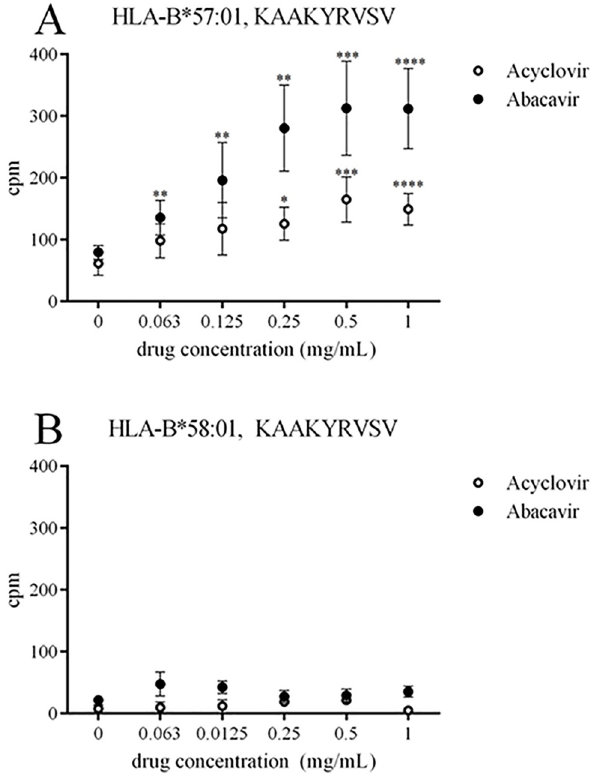
Fig 6. Acyclovir and abacavir alter the binding specificity of HLA-B * 57:01. The peptide KAAKYRVSV was radiolabeled and tested for binding to HLA-B * 57:01 in increasing doses of acyclovir and abacavir. Values are represented as geometric mean with 95% CI of four experimental runs in triplicates. Analysed by statistical significance by one-sided Mann Whitney test. * p < 0.05, ** p < 0.01, *** p < 0.001, **** p < 0.0001.